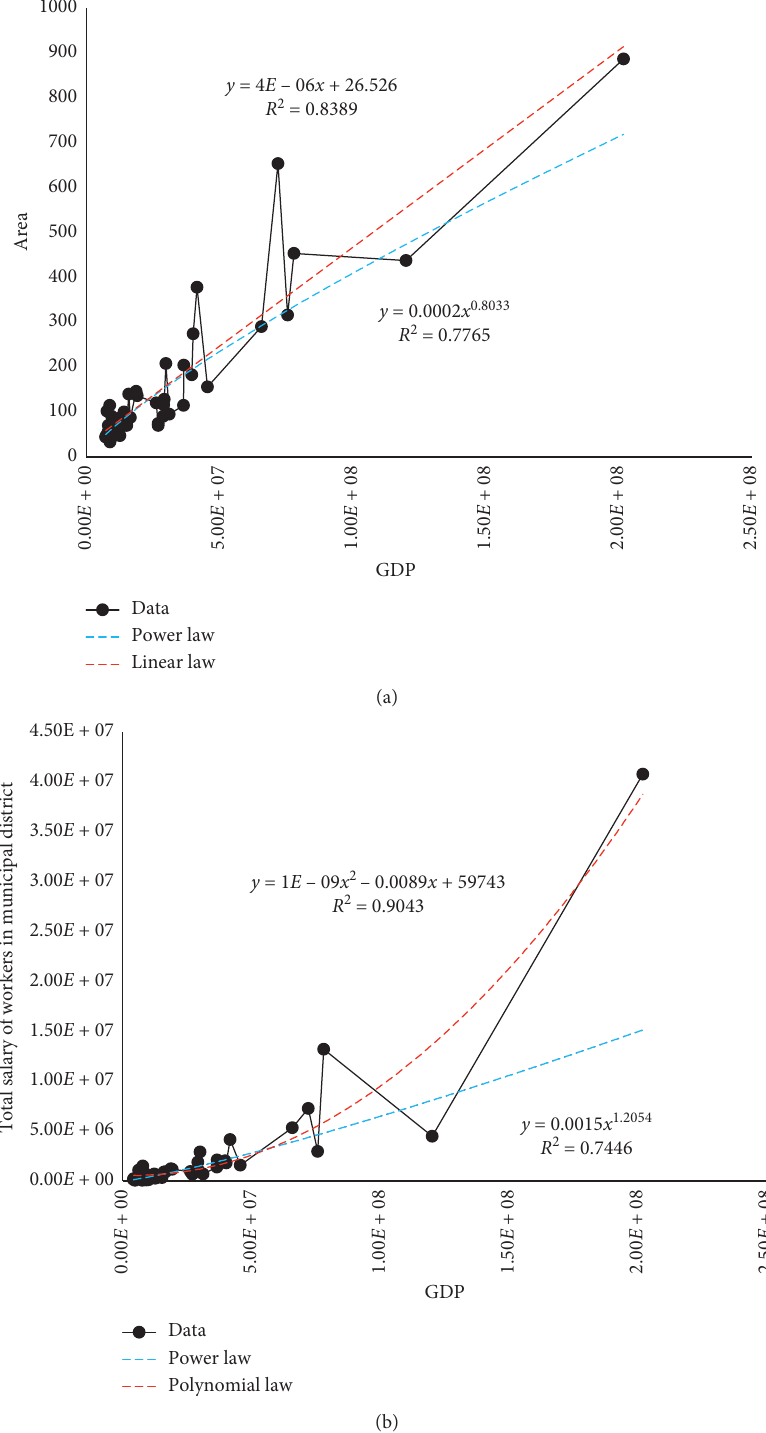
Figure 3: Allometric growth analysis. (a) Top 45 prefecture-level cities’ GDP-area. (b) 52 prefecture-level cities GDP-total salary of workers in municipal